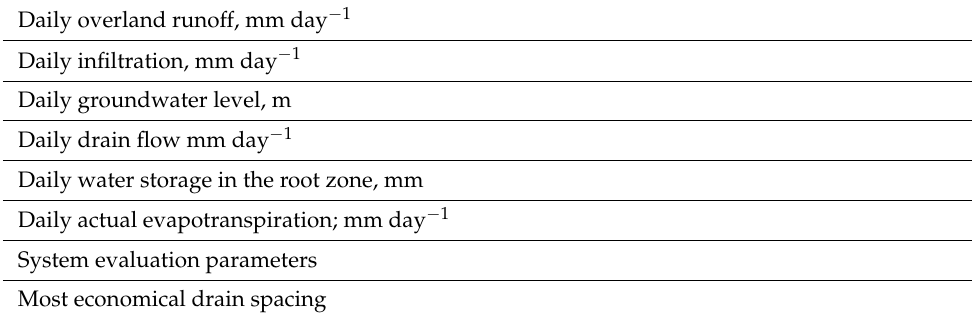
Table 2. SISDRENA output